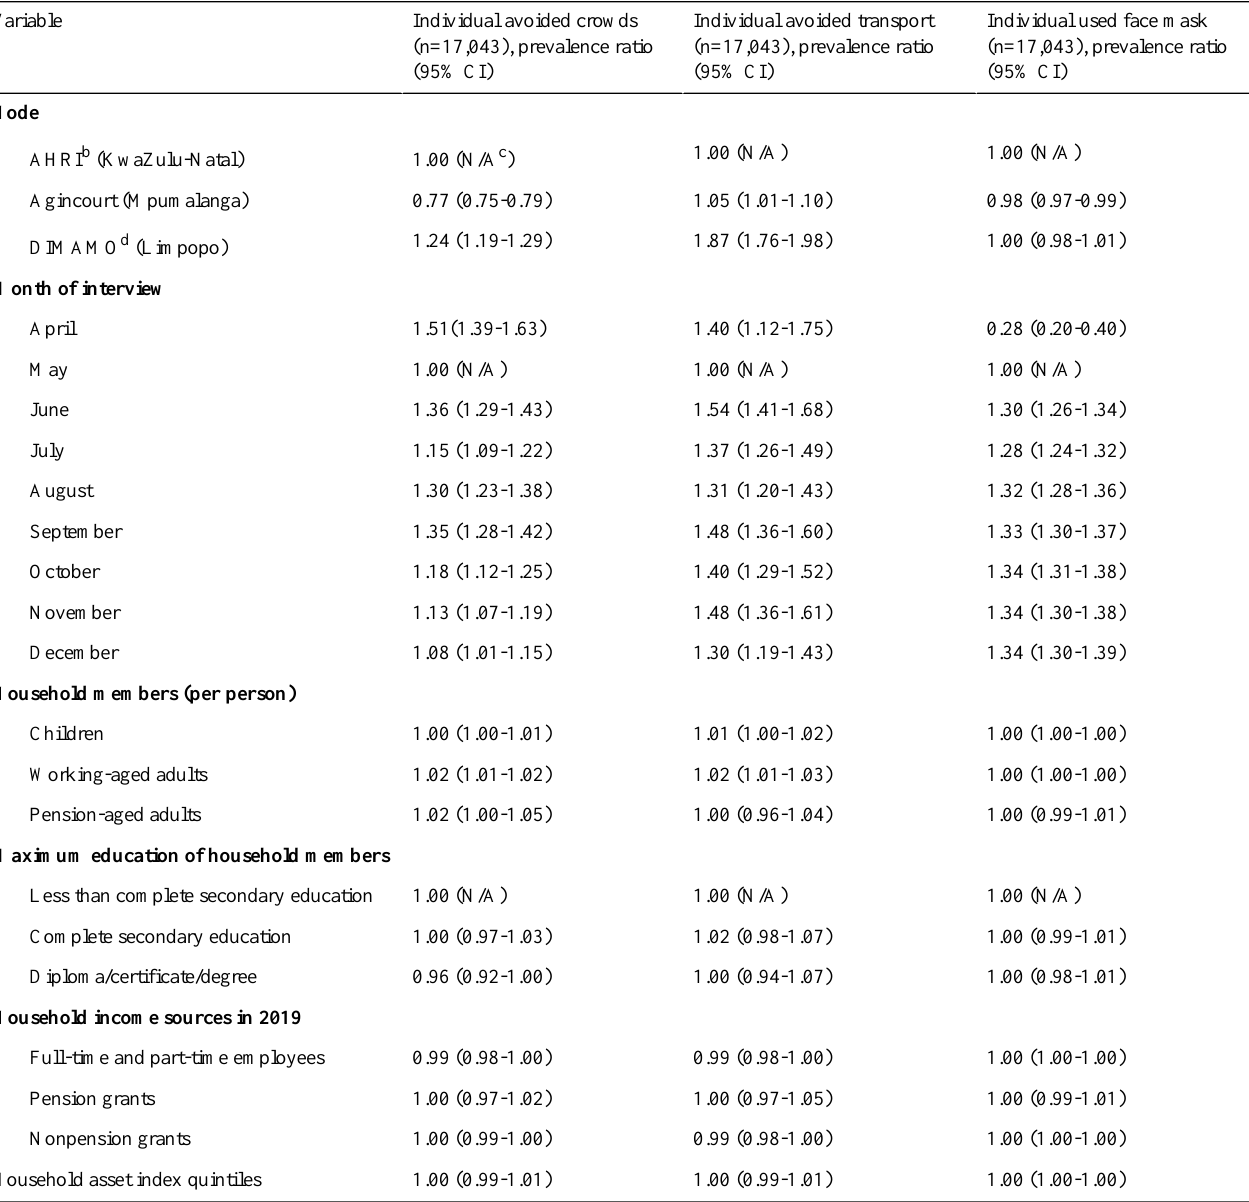
Table 3. Beyond-home behavior regarding COVID-19 at South African Population Research Infrastructure Network nodes from April to August 2020 a